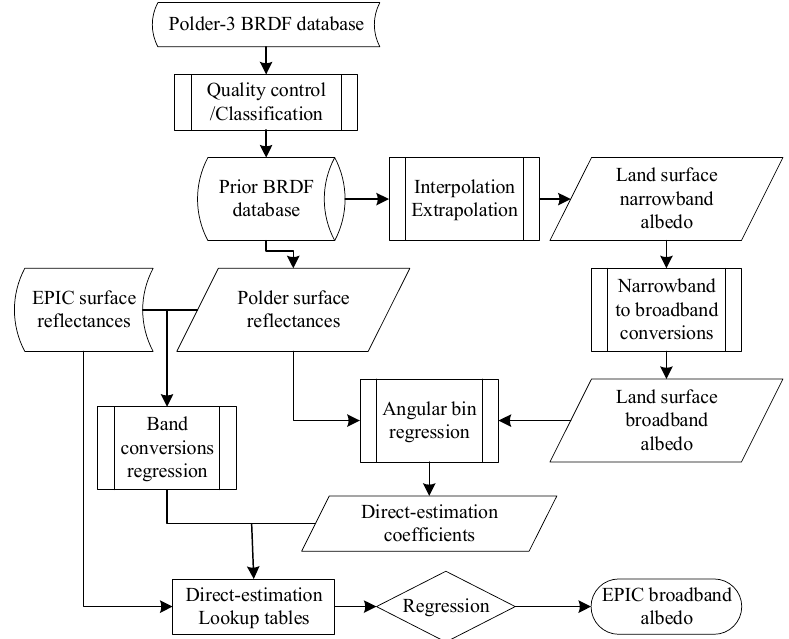
Figure 2. Flowchart for estimating surface broadband albedo from the Earth Polychromatic Imaging Camera (EPIC). Camera